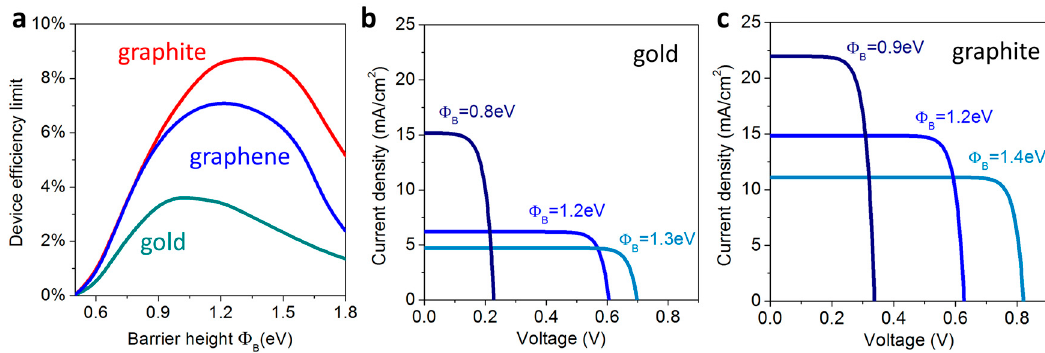
Figure 5. ( a ) Limiting IPE efficiencies as a function of the potential barrier height (teal: Au, blue: graphene, red: graphite); ( b , c ) Typical I–V curves for different barrier heights (shown as labels) for gold ( b ) and graphite ( c ).